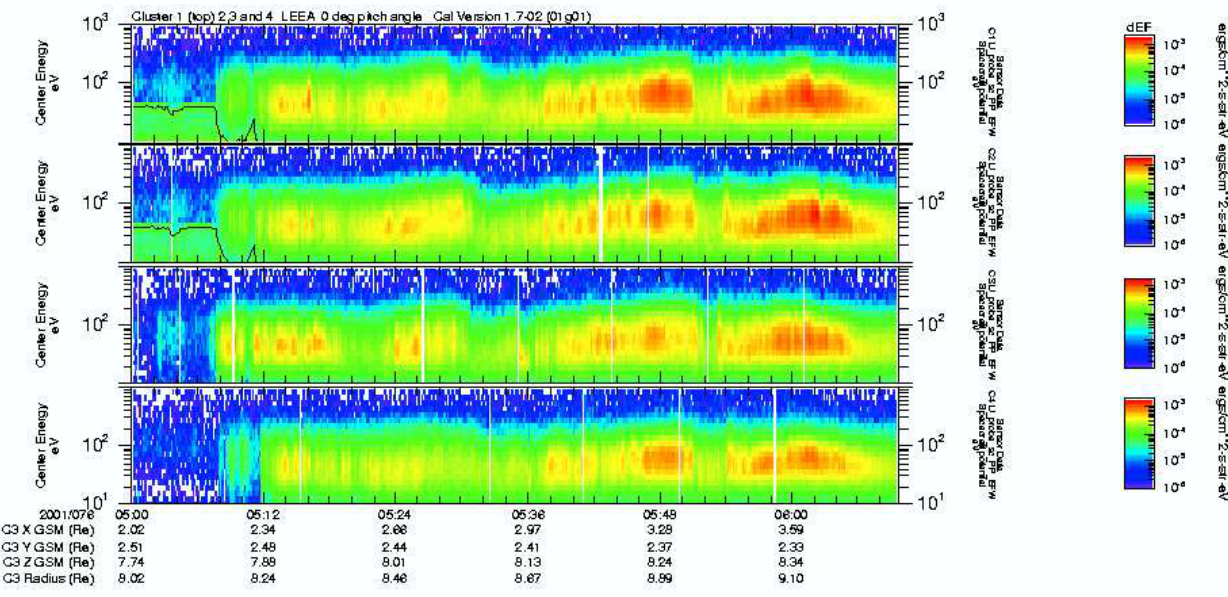
Fig. 4. Field-aligned electron fluxes observed by the LEEA instrument on the PEACE experiment between 05:00–06:00UT for all